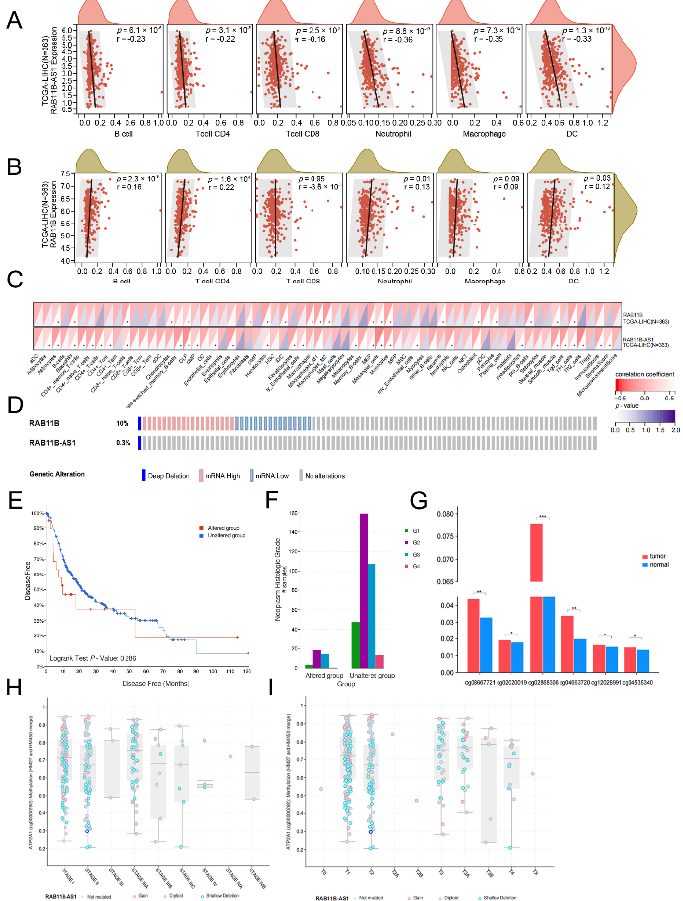
Figure 5. Copy number variations (CNVs) of RAB11B in HCC tissues ( A , B ) Correlation analysis between lnc-RAB11B-AS1 , RAB11B , and six immune cells in TIMER. ( C ) The relationship between the expression levels of two genes and 64 immune cells using xCell. ( D ) OncoPrint plot of lnc-RAB11B- AS1 and RAB11B alterations. ( E ) Genetic alteration in RAB11B might be associated with shorter OS of HCC patients. ( F ) Relationship between the gene mutation level of RAB11B and tumor histological grade. ( G ) Methylation levels of the promoter region of lnc-RAB11B-AS1 were higher in the tumor group compared to the paired normal group. ( H , I ) Methylation levels in different clinical stages and T stage. * p < 0.05, ** p < 0.01, *** p <